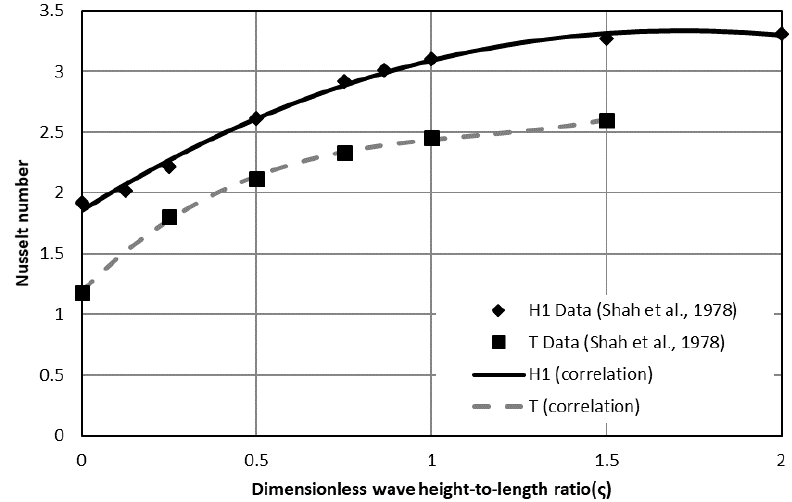
Figure 6. Data from Shah et al. [44] and correlations.